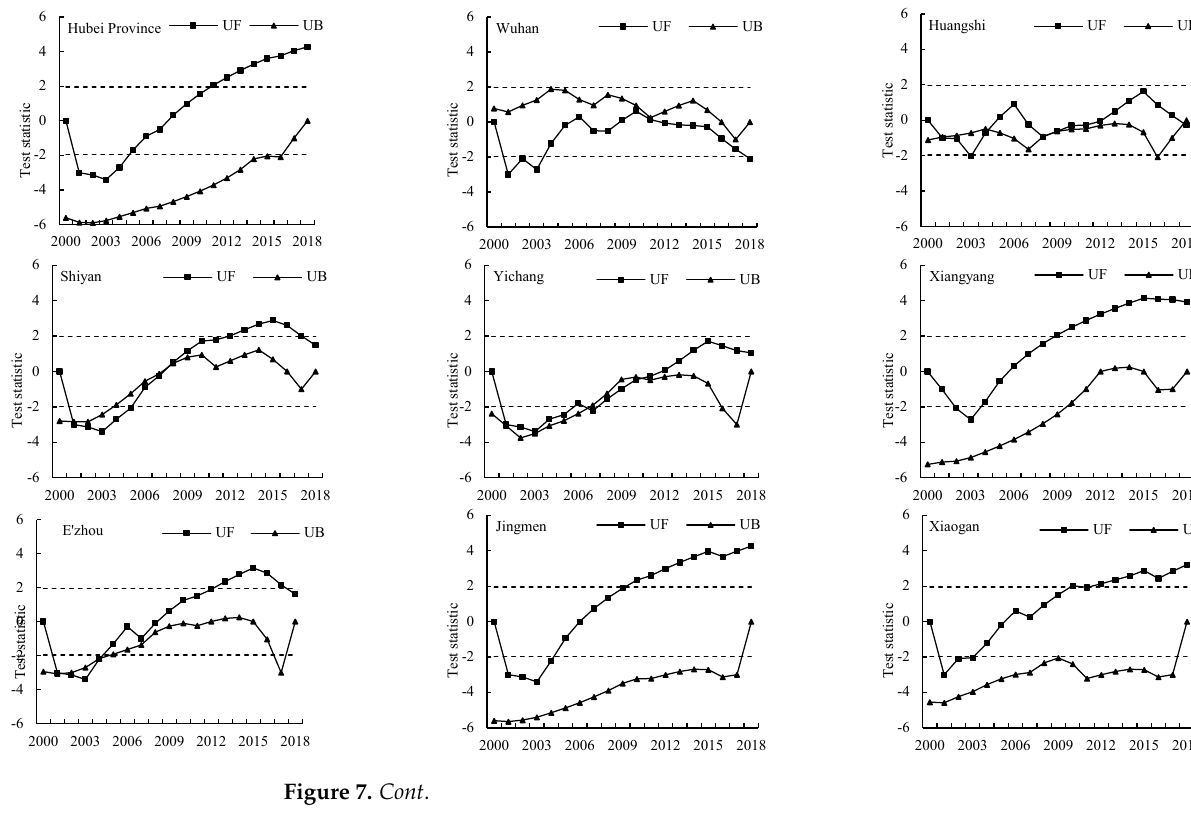
Figure 7. Trend variation and abrupt change test for grain yield between 2000 and 2018. The hori ‐ zontal dashed lines represent the critical values of the 0.05 significance level.